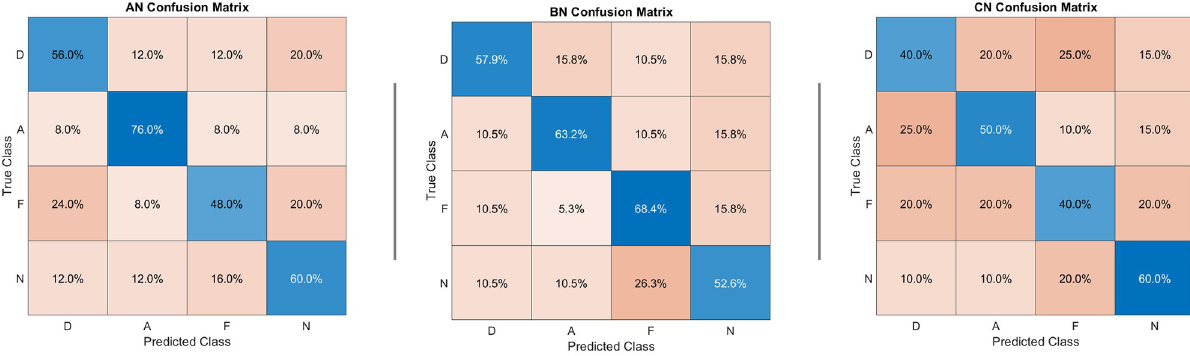
Fig 6. Confusion matrix. AN = Anorexia Nervosa, BN = Bulimia Nervosa, CN = Normal Controls. D = disgust, A = anger, F = fear, N = neutral. Predicted (by the MVPA) vs. real emotion for each stimulus presented during the functional MRI task. No pairwise comparison between matrices is significant.